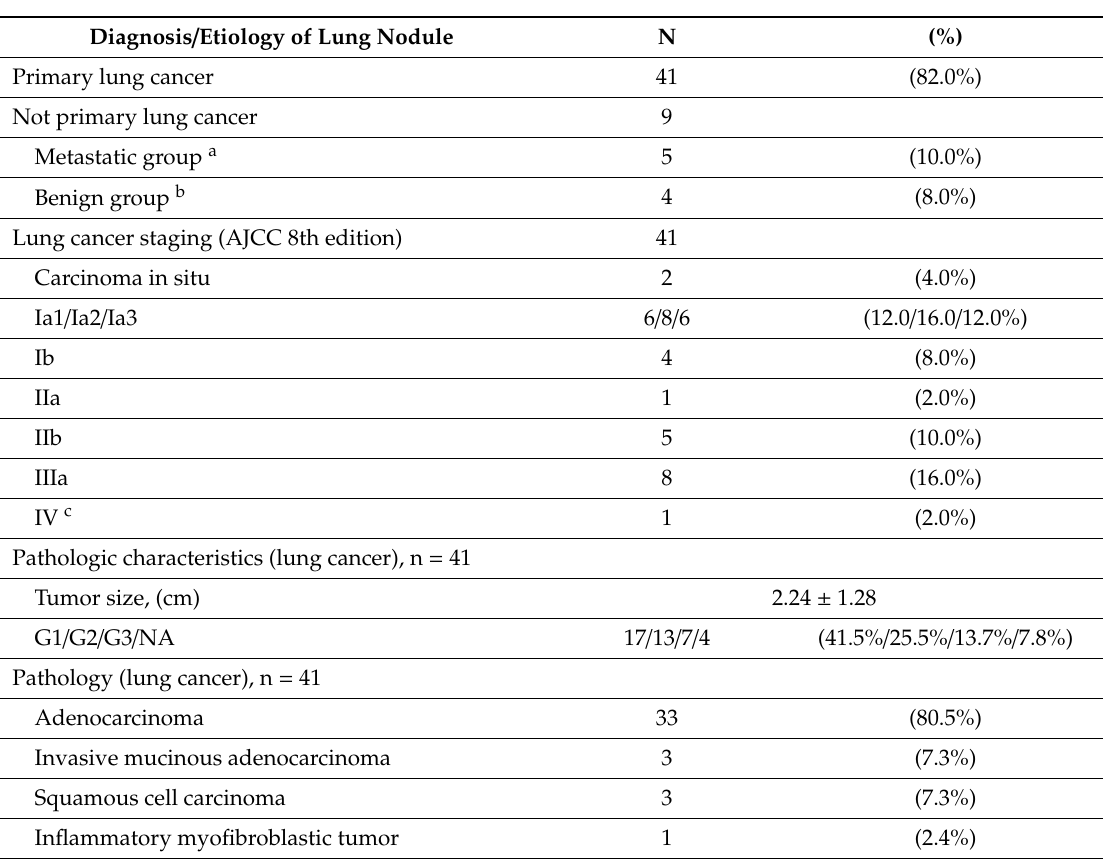
Table 3. Pathology characteristics of the study cohort (N = 50). AJCC, American joint committee on cancer; NA, not